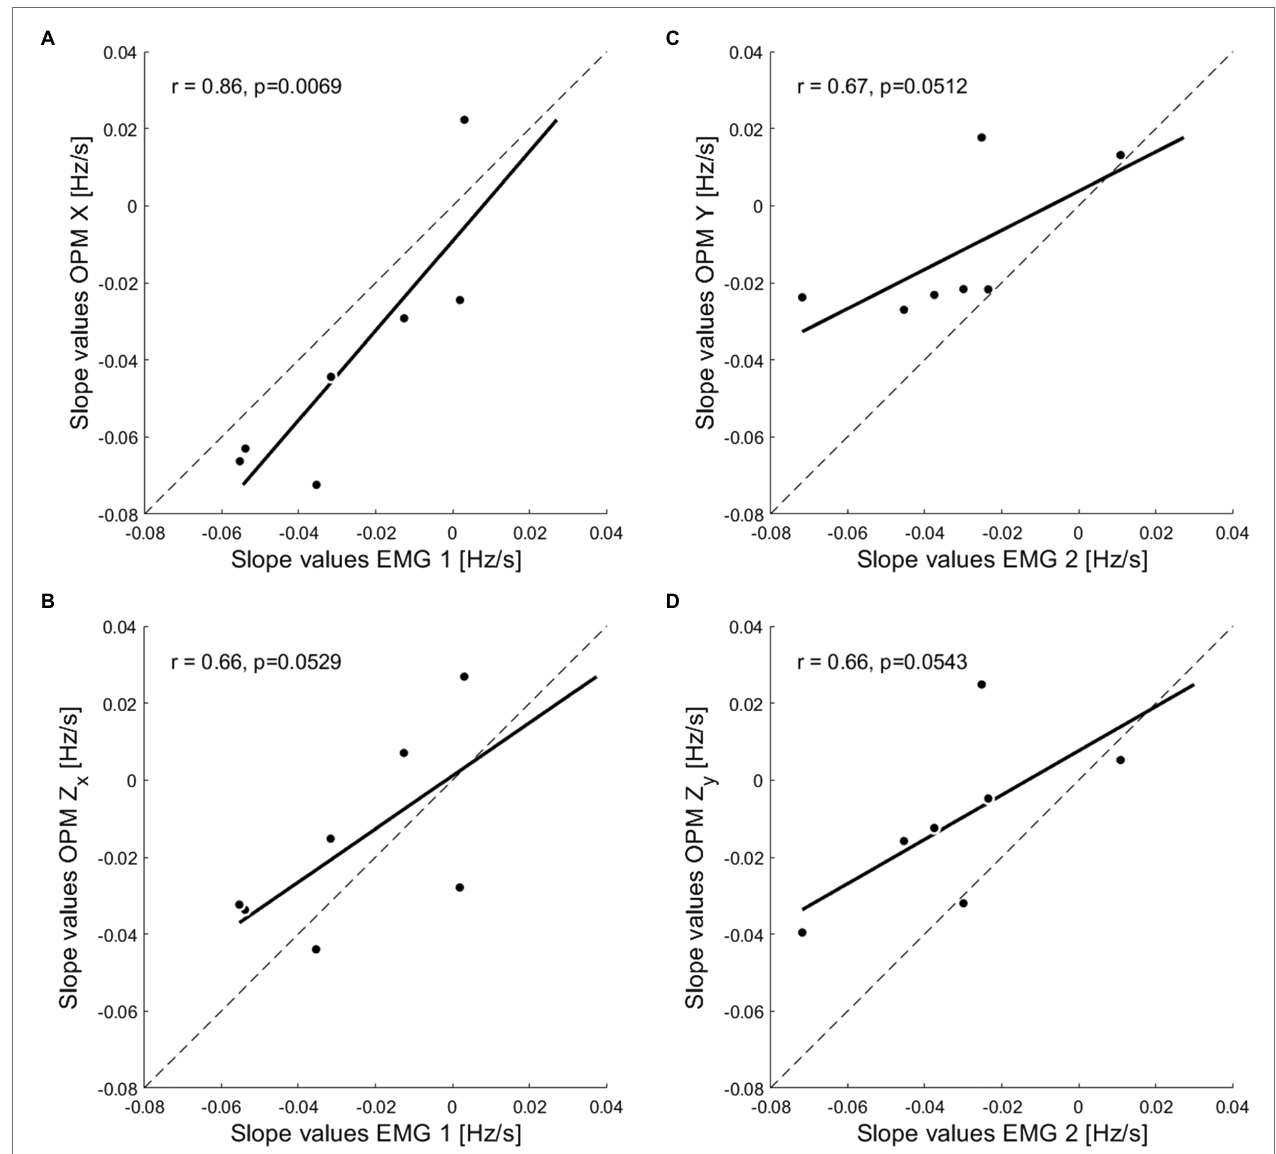
FIGURE 4 | Correlation between OPM-MMG and sEMG single subject’ slope values. Pearson’s r coefficients obtained by correlating the single subjects’ slope values of each OPM vector components, with the slope values of the corresponding EMG measurement. (A,B) Correlations of the X and the orthogonal Z X components with EMG measurement 1. (C,D) Correlations of the Y and the orthogonal Z Y components with EMG measurement